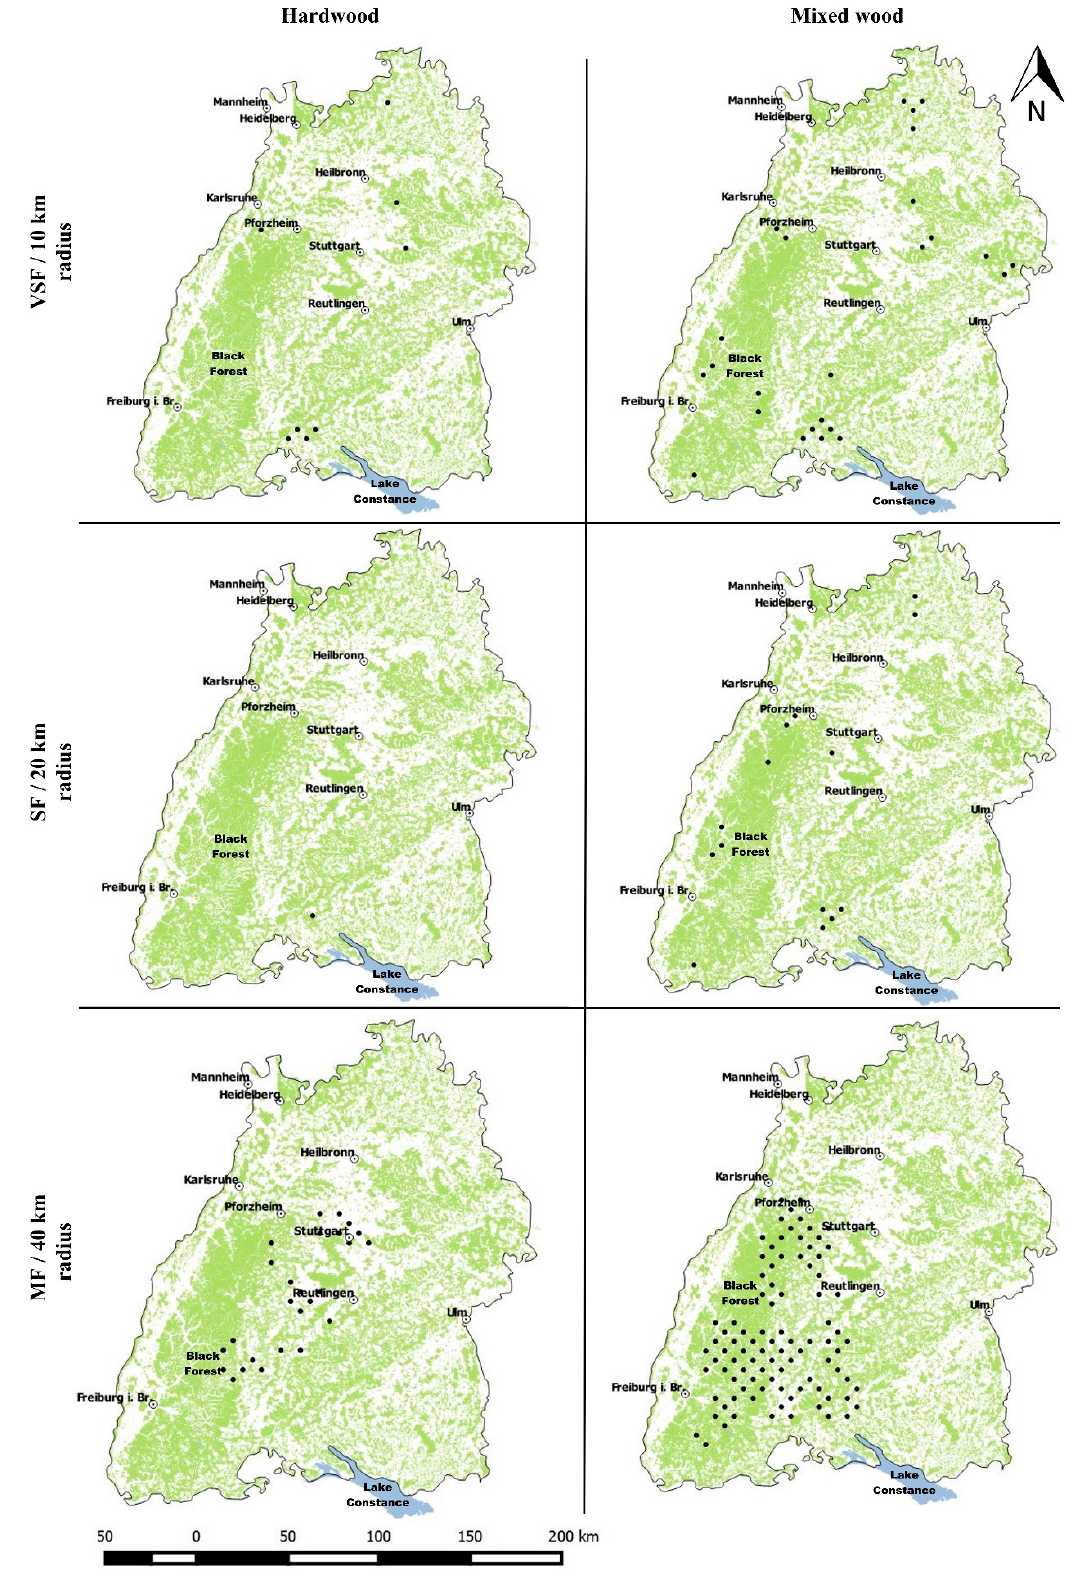
Figure 4. The federal state of Baden-Württemberg: vegetation in green, large lakes in blue, cities > 100,000 inhabitants as white circles labelled with their name. The suitable positions for the six scenarios are shown as black dots.